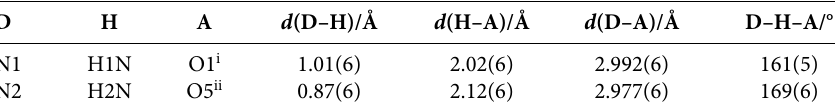
Table 2. Hydrogen Bonds for 3